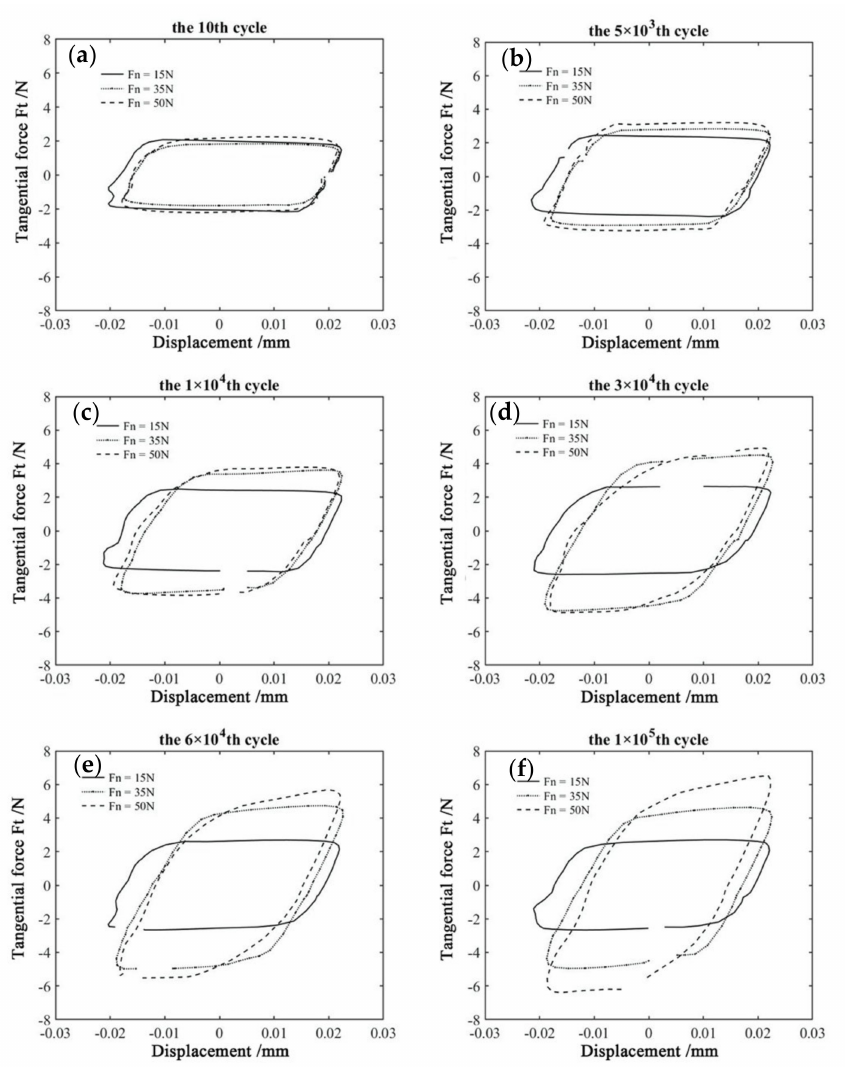
Figure 8. The comparison of F t − d curves of PVDF thin films in different number of cycle with D = ± 20 µ m, ƒ = 15 Hz, and V c = 0 V: ( a ) 10th, ( b ) 5 × 10 3 th, ( c ) 1 × 10 4 th, ( d ) 3 × 10 4 th, ( e ) 6 × 10 4 th, and ( f ) 1 × 10 5